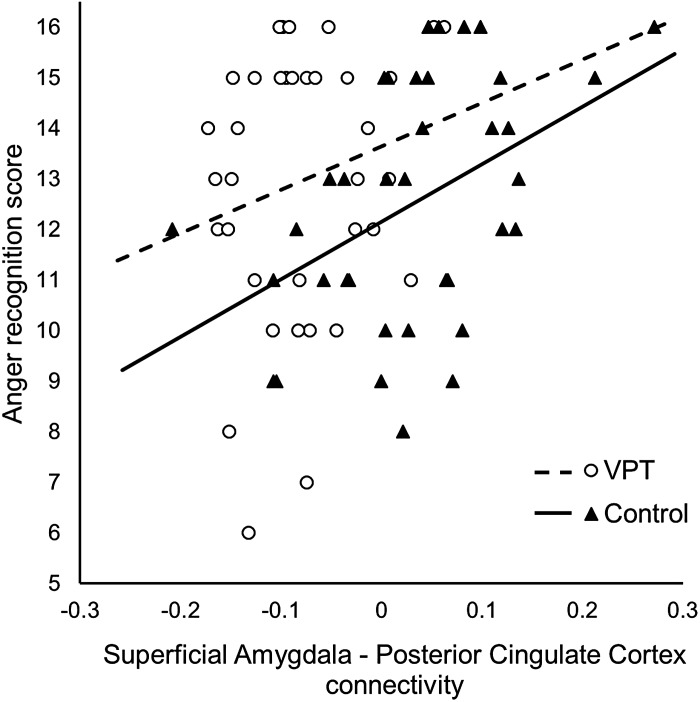
Correlation between superficial amygdala-posterior cingulate connectivity and
Emotion Recognition Task score for anger in very preterm birth (VPT) participants
(white dots; Spearman's ρ = 0.172) and controls (black triangles;
Spearman's ρ = 0.426). Least-squared lines are shown for
illustrative purposes only and do not constitute a formal test.